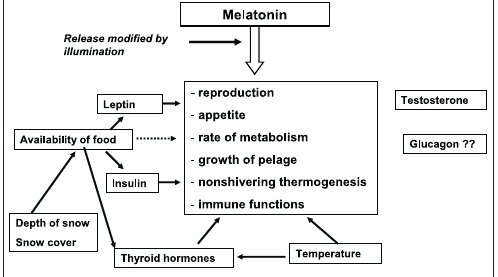
Fig. 3. Release of melatonin from the pineal gland is regulated by photoperiod, and the physiological effects of the melatonin are modified by several other hormones the concentrations of which also show seasonal